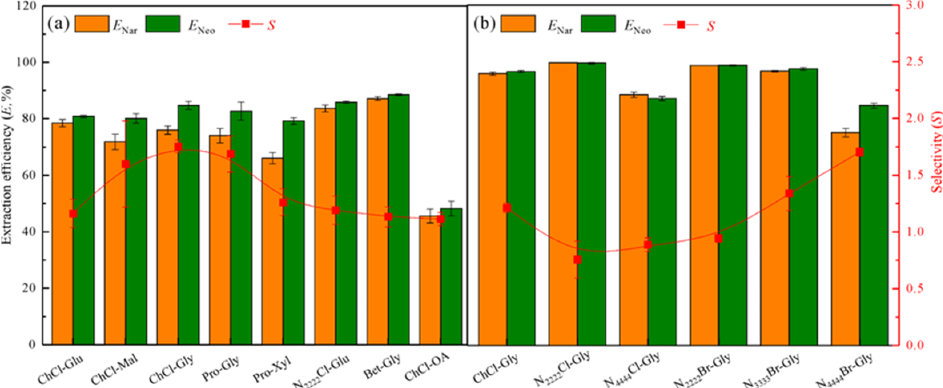
Figure 3. E and S values for Nar and Neo in different ETPSs. The extraction conditions were as follows: ( a ) DESs of 30 wt%, PL 64 of 35 wt%, temperature of 25 °C, ( b ) DESs of 43 wt%, PL 64 of 43 wt%, temperature of 25 °C.